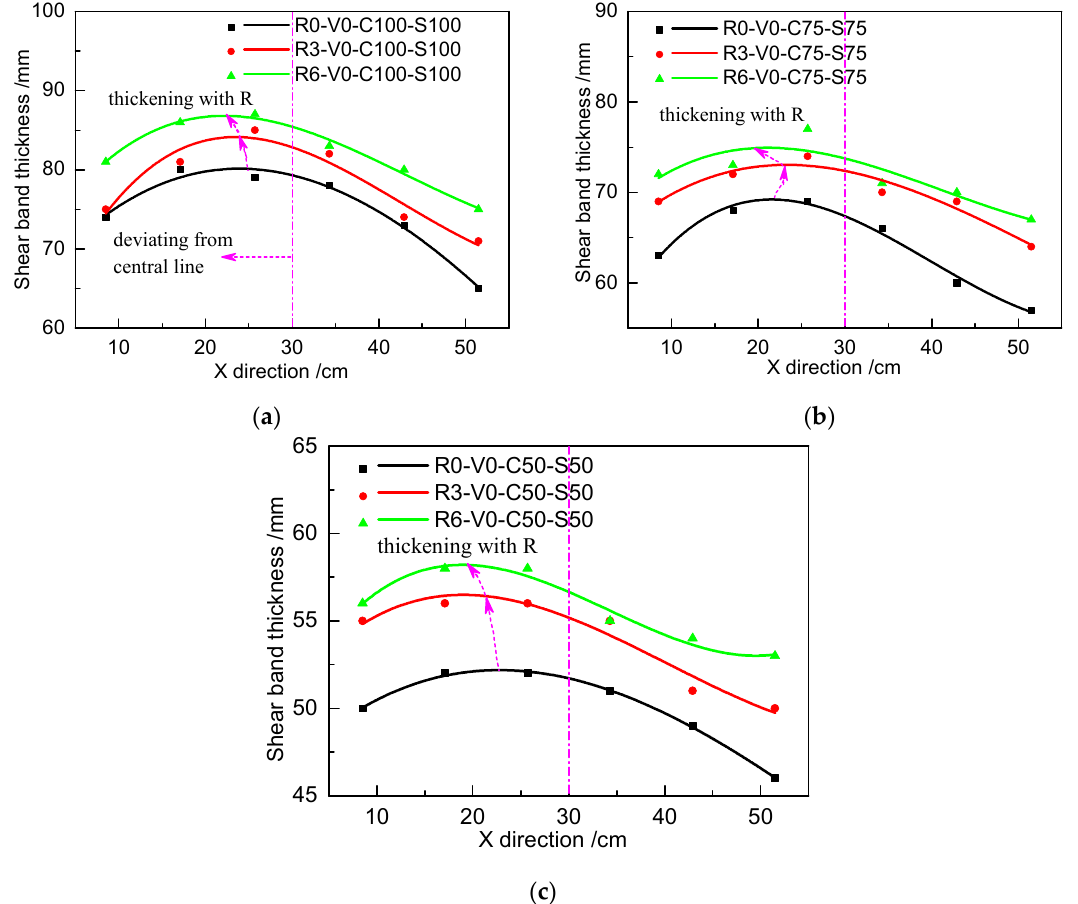
Figure 16. Relationship of the distribution and thickness of the shear band with different roughness values in different loading cases: ( a ) C100 and S100; ( b ) C75 and S75; and ( c ) C50 and S50. Materials 2020 , 13 , 3043 Table 8. Average shear band thickness for specimens with different roughness values and no grouting